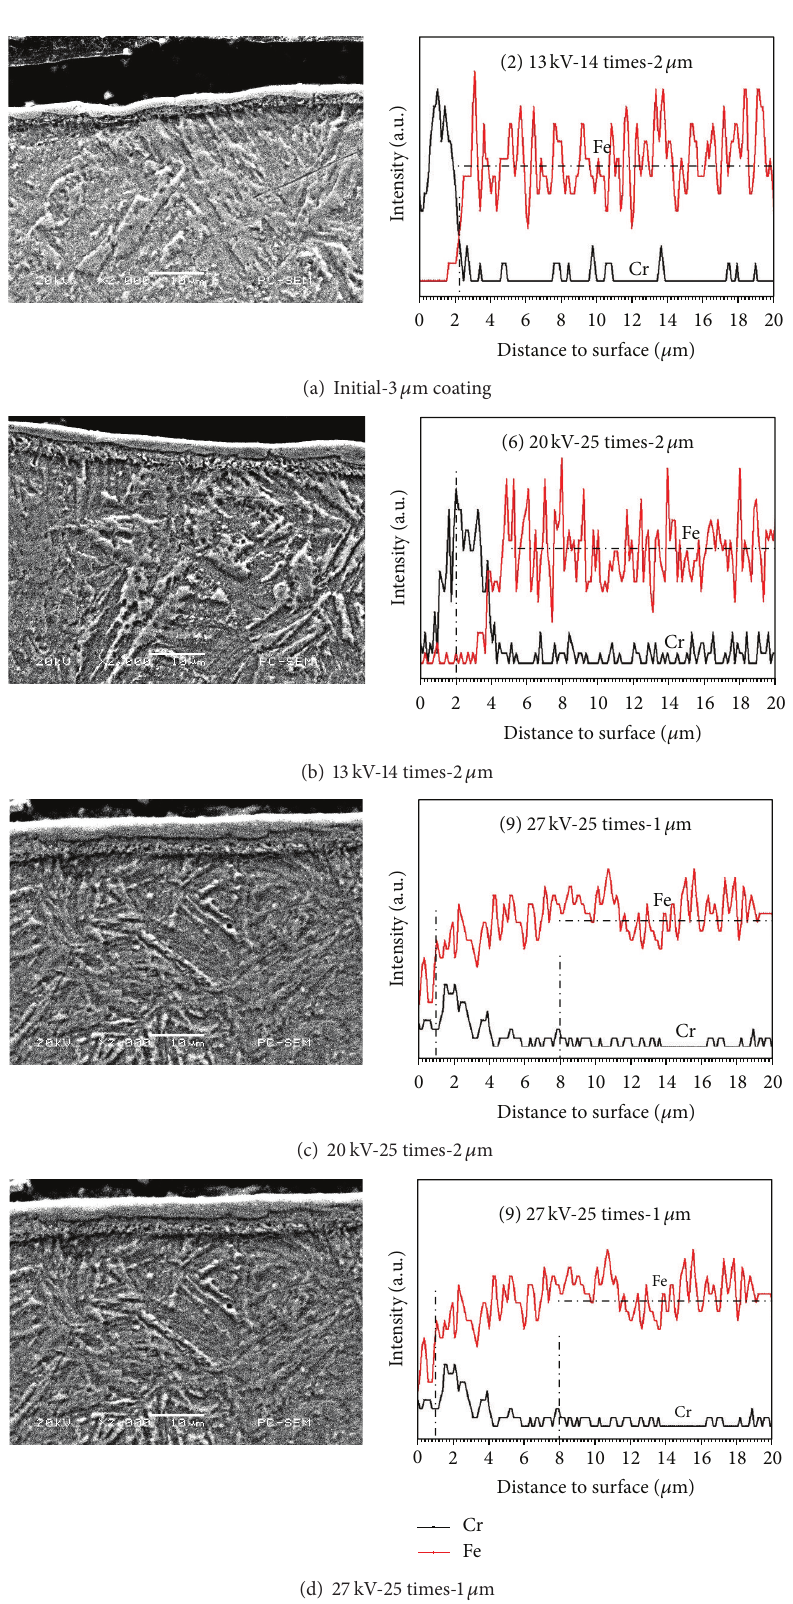
Figure 3: Cross-section morphology and spectral